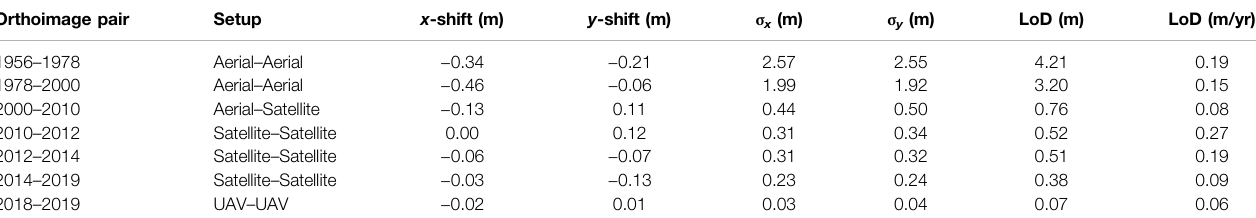
TABLE 3 | Assessment of the horizontal displacement accuracy of orthoimage pairs over stable terrain. Orthoimage pair